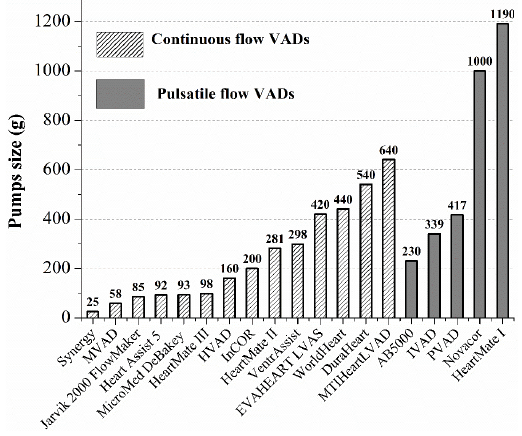
Figure 4: Pump size comparison of